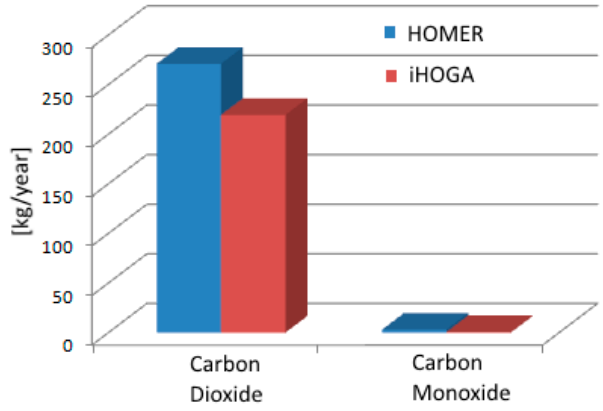
Figure 21. Comparison of pollutant emissions resulting from the two simulators.